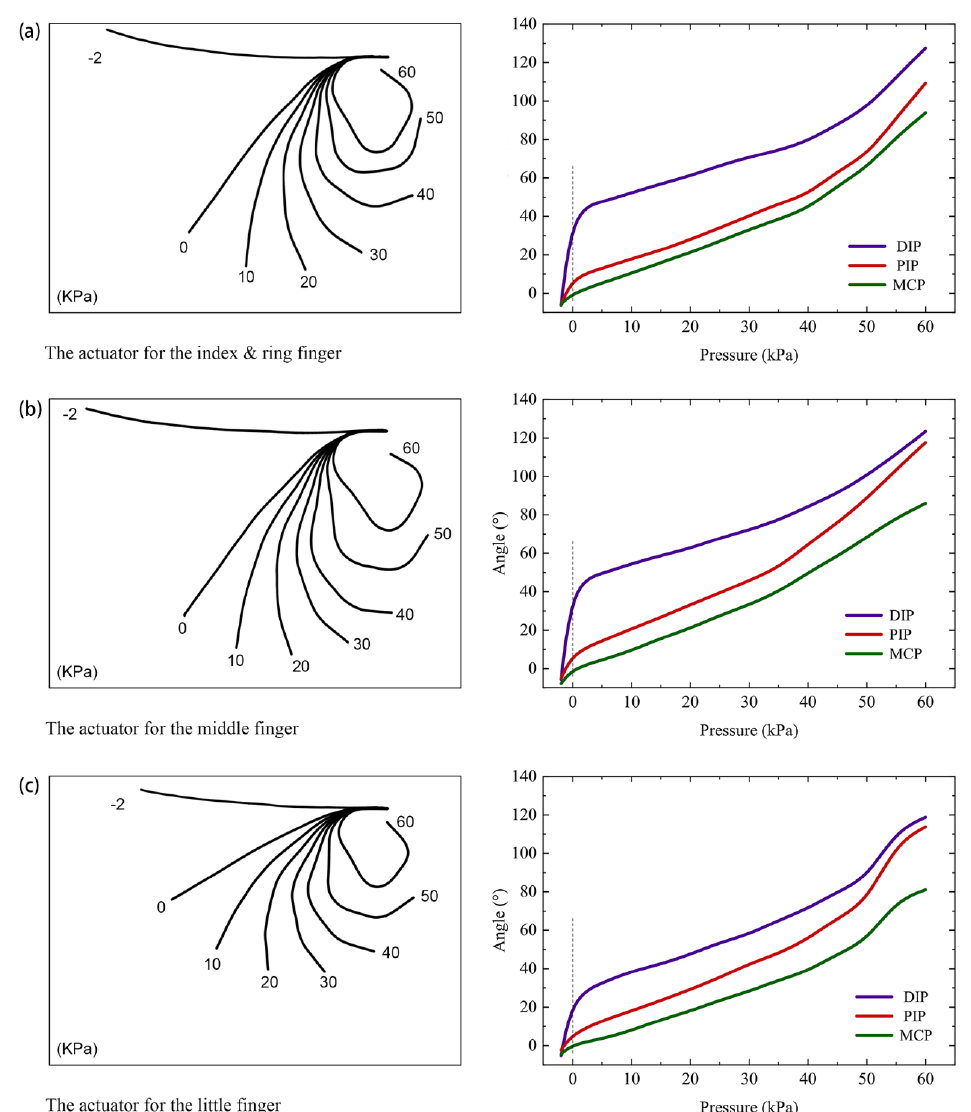
Figure 12. Actuator performance under different air pressure. ( a ) The results for the actuator of 128 mm length. ( b ) The results for the actuator of 133 mm length. ( c ) The results for the actuator of 108 mm length.